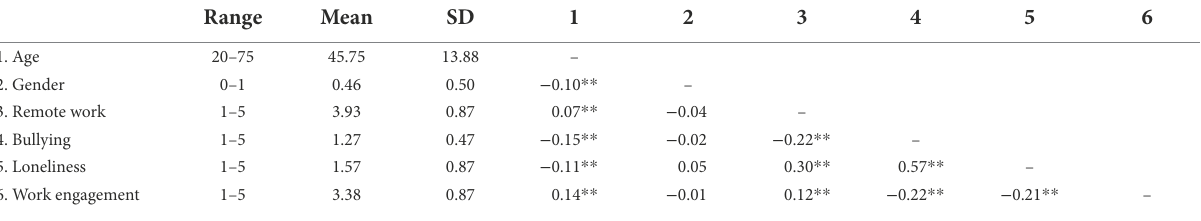
TABLE 2 Descriptive statistics and correlations.